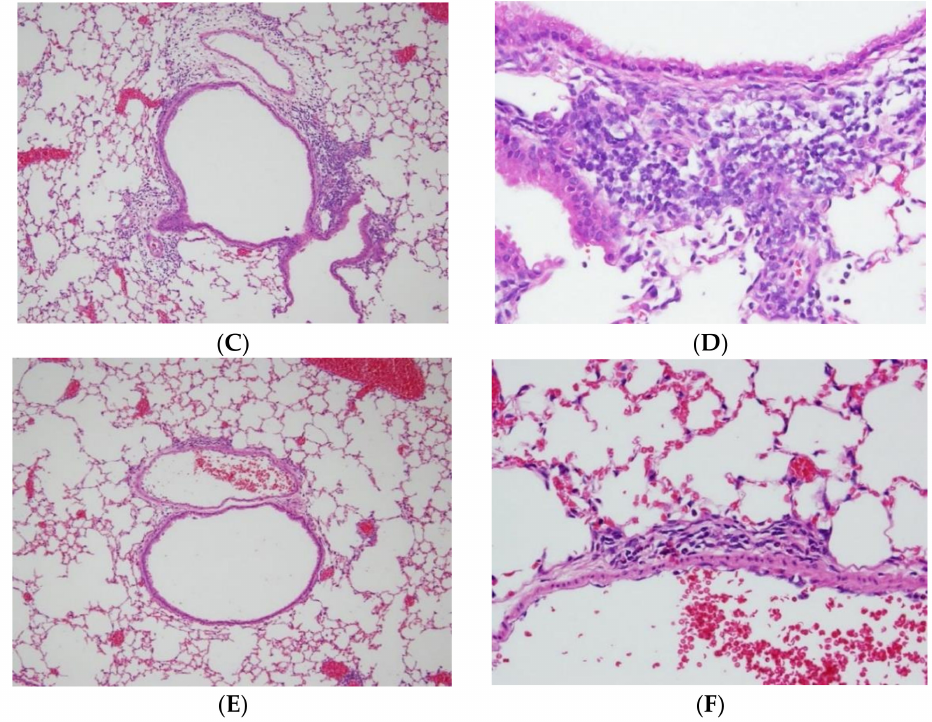
Figure 2. Histopathological findings of the lungs were found in the OVA-induced bronchiolitis mice. There were normal architectures of bronchioles of the lungs in a NSC mouse (( A , B ), NCL3-2); OVA-induced lungs, shown as focal inflammatory cell infiltration, mainly neutrophils, lymphocytes, and (fairly) eosinophils, around perivascular and peribronchial spaces, which were, respectively, graded as slight (2) in the DC group (( C , D ) DC3-1); and minimal (1) in the PC group (( E , F ), PC3-3); H&E stain; 100 and 400 × .